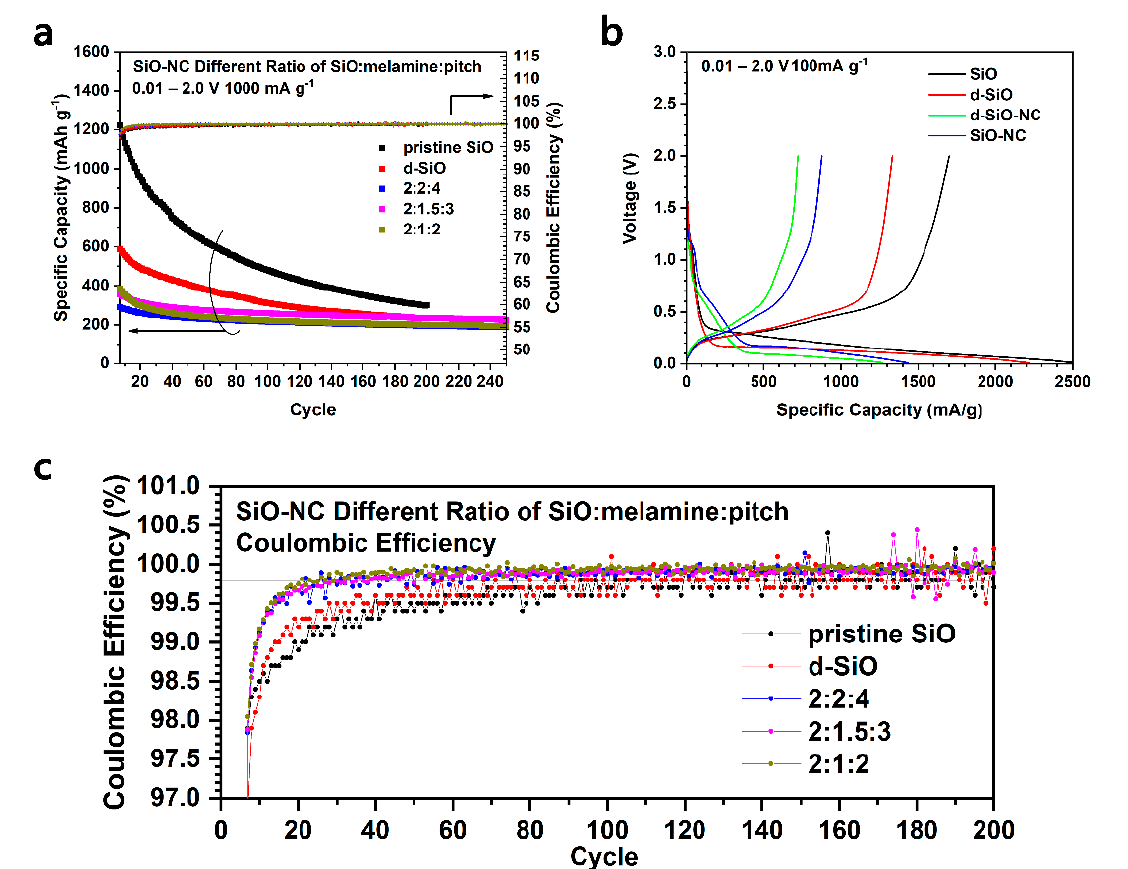
Figure 6. Cycling performance ( a ) and Coulombic efficiency ( c ) of pristine SiO, d-SiO, SiO-NC with different ratio of raw materials. ( b ) First charge/discharge voltage profile of SiO, d-SiO, d-SiO-NC (2:1.5:3) and SiO-NC (2:1.5:3).